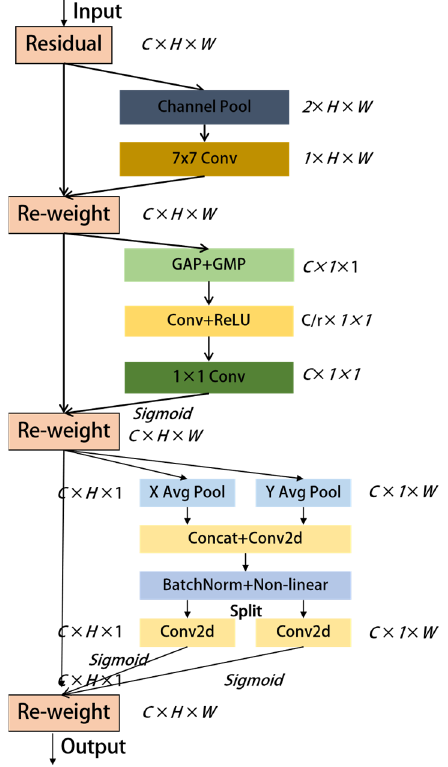
Figure 5. Diagram of the CBAM-CA module .